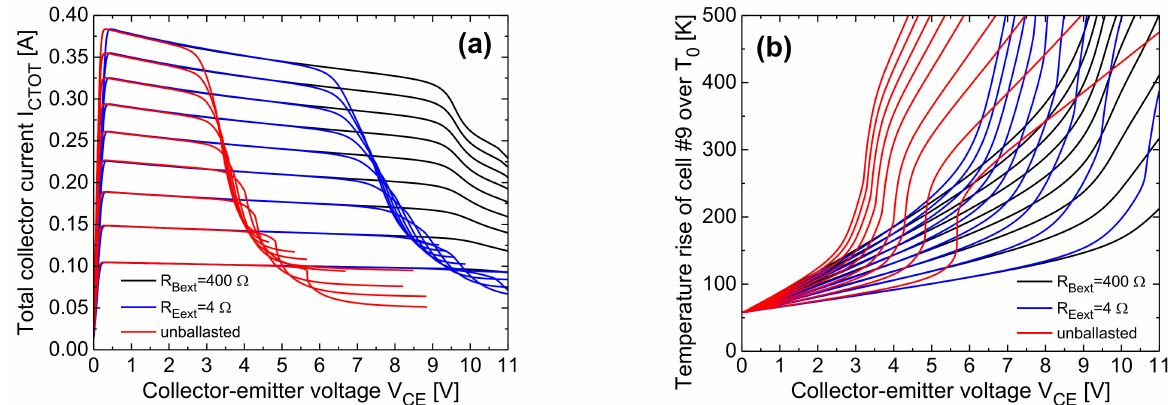
Figure 23. Simulated ( a ) total collector currents and ( b ) junction temperature rises above T 0 of cell #9 against collector- emitter voltage V CE for half of the 24-cell array biased with I BTOT = 1, 1.5, 2, 2.5, 3, 3.5, 4, 4.5, 5 mA. Comparison between the case with no ballasting (red lines), and those benefiting from R Bext = 400 Ω (black) and R Eext = 4 Ω (blue) per